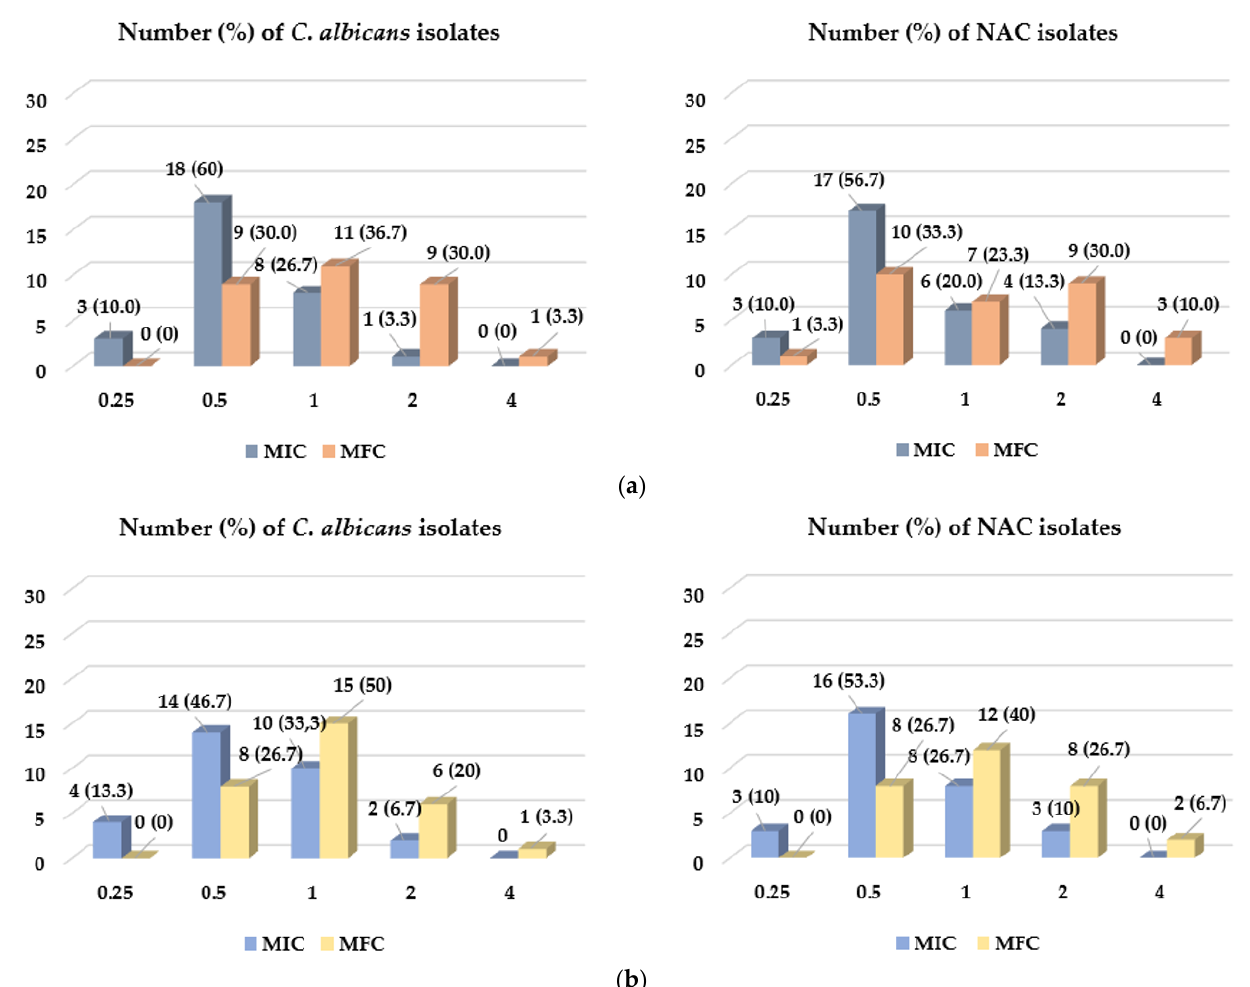
Figure 3. Distribution of MIC (minimal inhibitory concentration) and MFC (minimal fungicidal concentration) values [mg/mL] of CEO ( a ) and EUG ( b ) among clinical isolates of C. albicans (30 isolates) and non‐albicans Candida spp. (NAC) (30 isolates) from hospitalized patients with hematological malignancies.